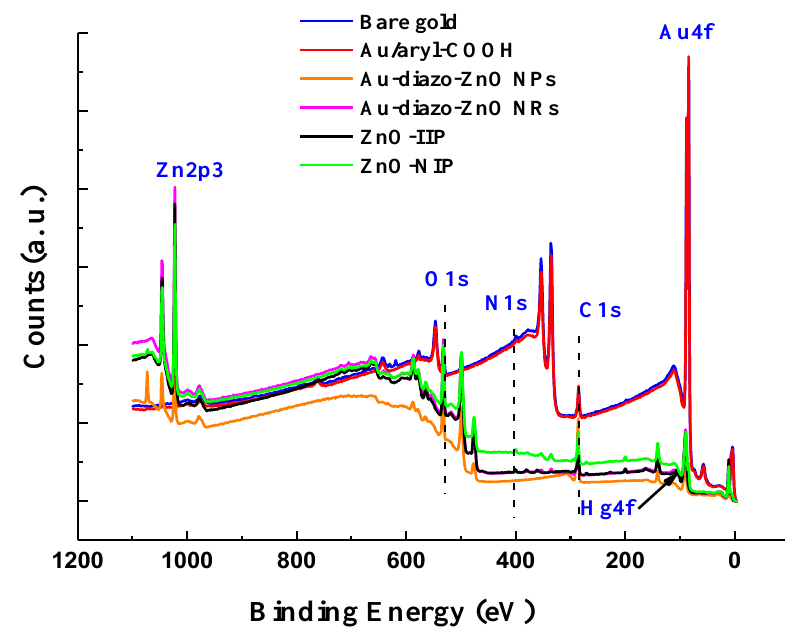
Figure 5. XPS survey scans of Au electrode, Au/diazo-COOH, Au-diazo-ZnO nanoparticles, Au-diazo-ZnO nanorods, ZnO-IIP and ZnO-NIP. Firstly, comparison of the XPS spectrum of bare gold electrode with Au/diazo-COOH confirms the effective reductive electrografting reaction of the diazonium salt on the gold electrode. Indeed, it is noticed the presence of characteristic signals of the diazo-COOH, namely C1s and N1s peaks centered at 285 eV and 400 eV, respectively (Figure 5). It should be noted that the surface-grafted layer seems to be relatively thin (less than 10 nm); this was also confirmed by the atomic percentages